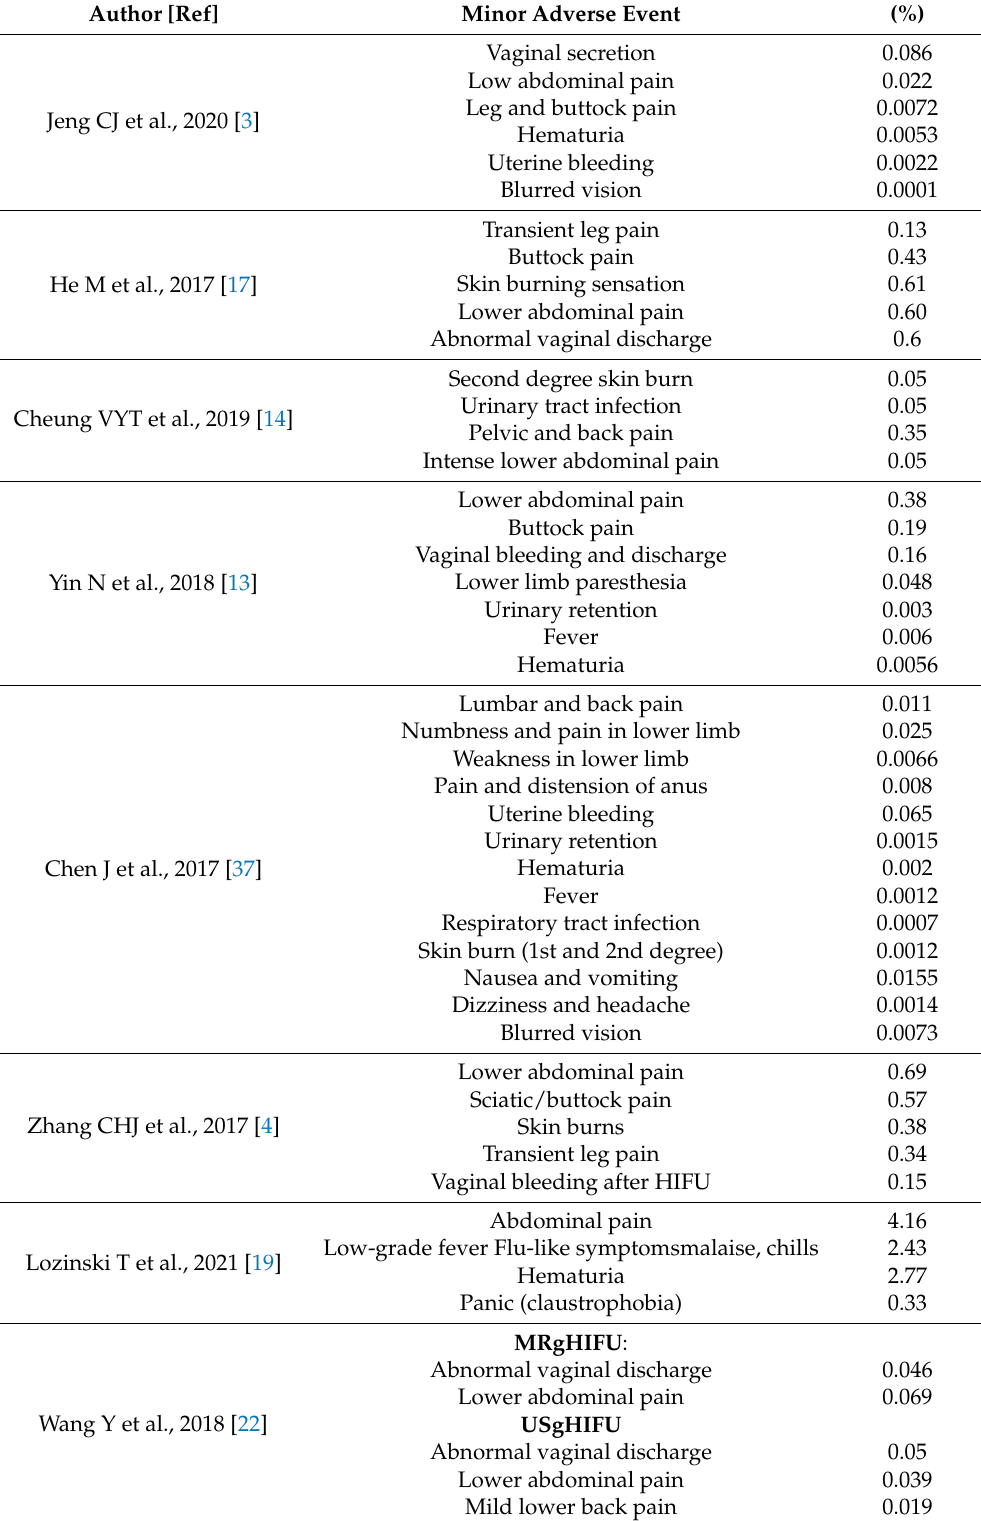
Table 5. Frequency of minor adverse events after HIFU therapy reported in clinical